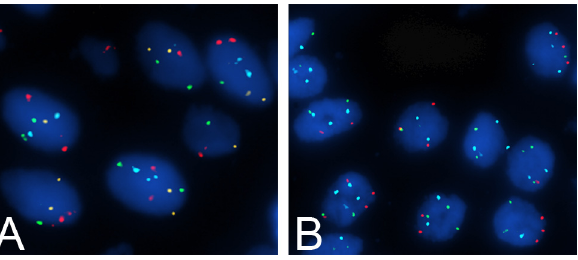
Fig 4. FISH results for the two tumor types. The cases that exhibited a gain of at least 2 of chromosomes 3 (B) , 7 (B) and 17 (A, B) or a homozygous loss of 9p21 (B) were defined as UroVysion FISH positive.